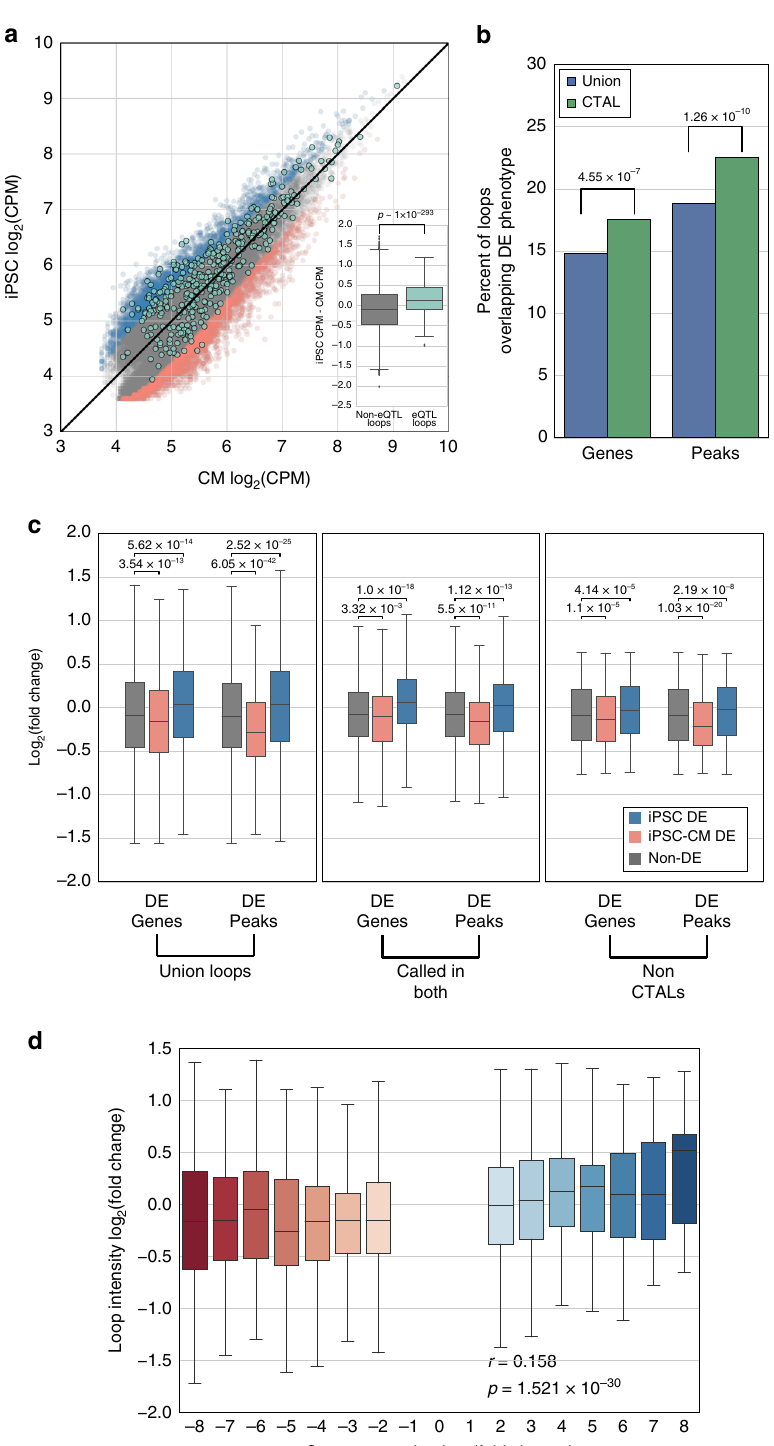
propensity and differential expression, as well as the quantitative association between contact propensity and differential H3K27ac, across cell types. We tested whether the fold change in contact frequency across cell types was in the direction of the cell type with higher differential expression or H3K27ac. We found that across the union loop set, anchors overlapping DE genes with higher expression in iPSCs had signi fi cantly greater contact